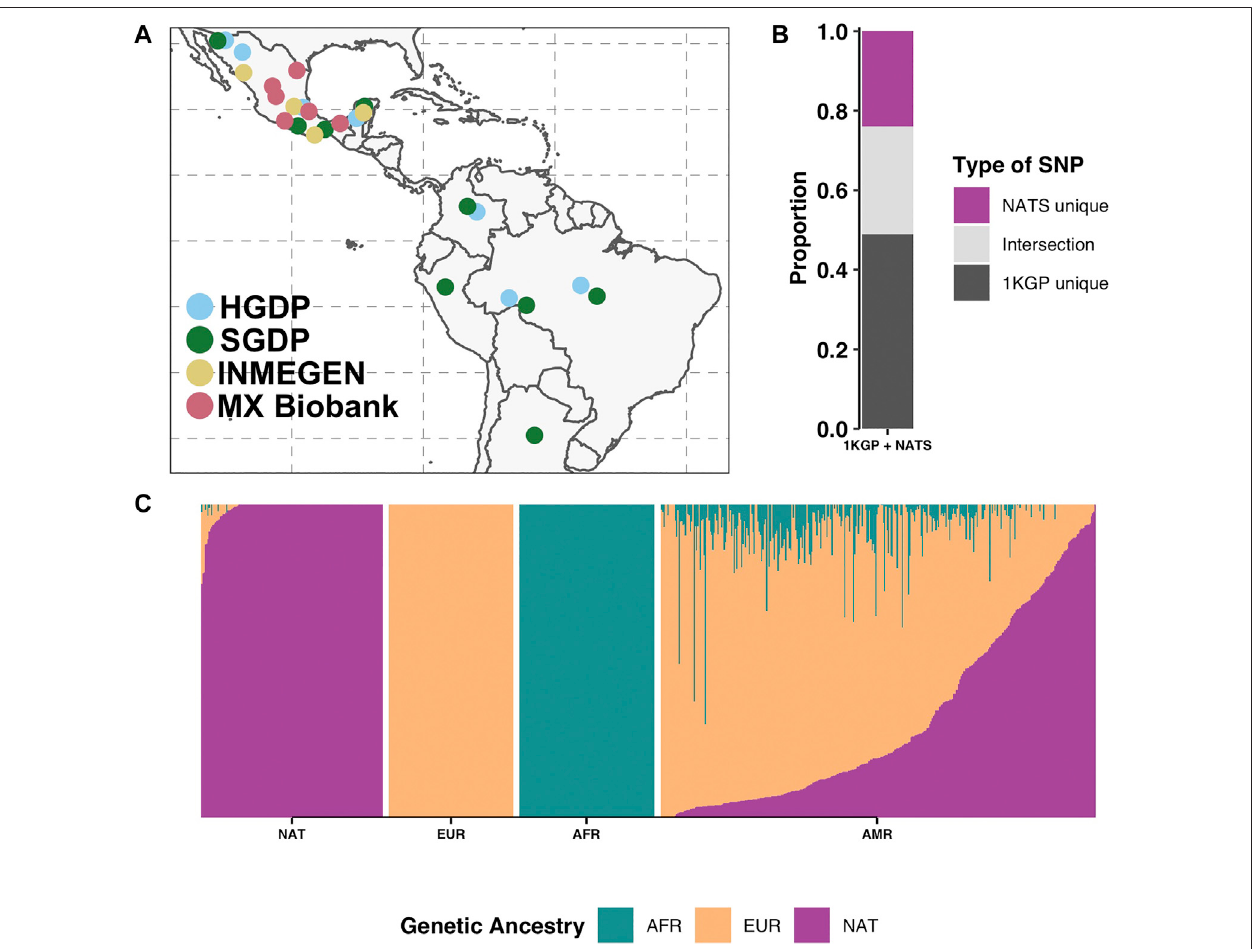
FIGURE 1 | Native American reference panel (NATS). (A) Geographical sampling locations of the NATS reference panel. Colors represent the four data sources: HGDP(61)(Bergström et al., 2020),SGDP(11)(Mallick et al., 2016),INMEGEN (12)(Romero-Hidalgo et al.,2017),and MX Biobank(50)totaling 134genomes. (B) SNP proportions of the union of 1KGP and NATS (1KGP + NATS) by SNP sharing categories. We show the proportion of SNPs unique to 1KGP, SNPs unique to the NATS panel, and the intersection. (C) Unsupervised ADMIXTURE analysis at K (cid:1) 3 of the NATS reference panel (far left, N (cid:1) 134) together with 104 European (CEU), 113 African (YRI), and 347 admixed Latin American (AMR) samples from 1KGP. Genetic ancestry abbreviations: AFR — African, EUR — European, NAT — Native American.